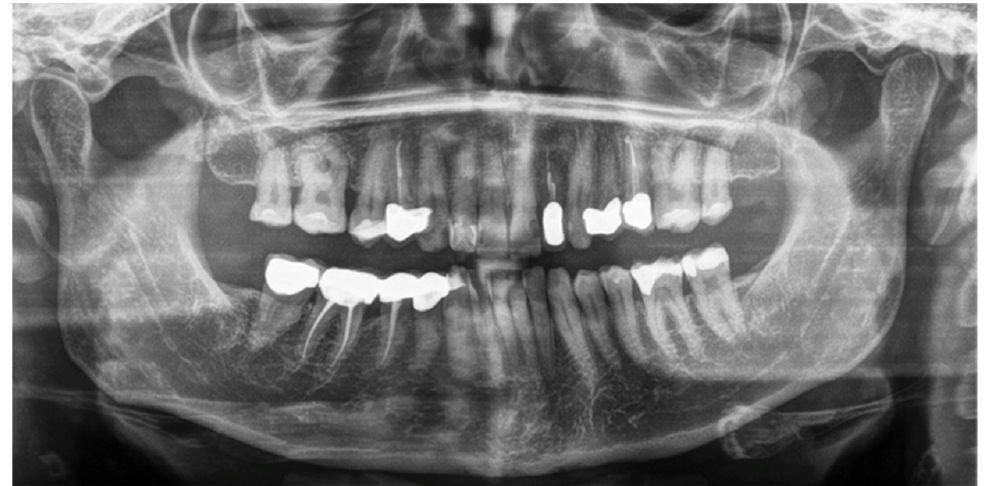
Figure 2. The panoramic radiograph was significant for aspecific signs: mild bone trabecular thickening around the first right molar roots without apical rarefaction or periodontal marginal bone reabsorption.